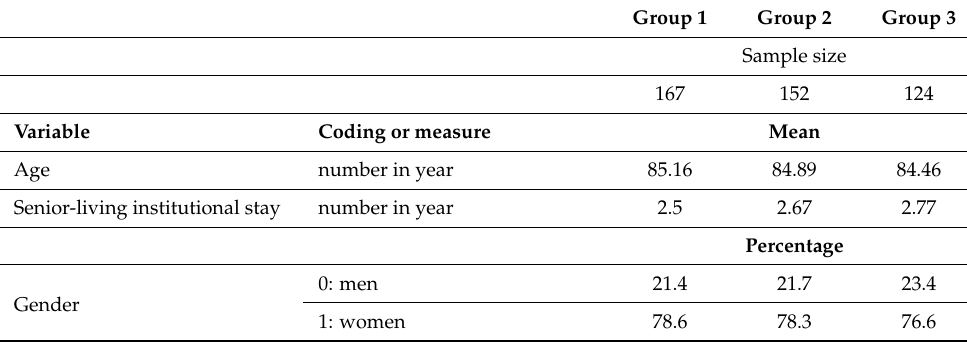
Table 1. Characteristics of